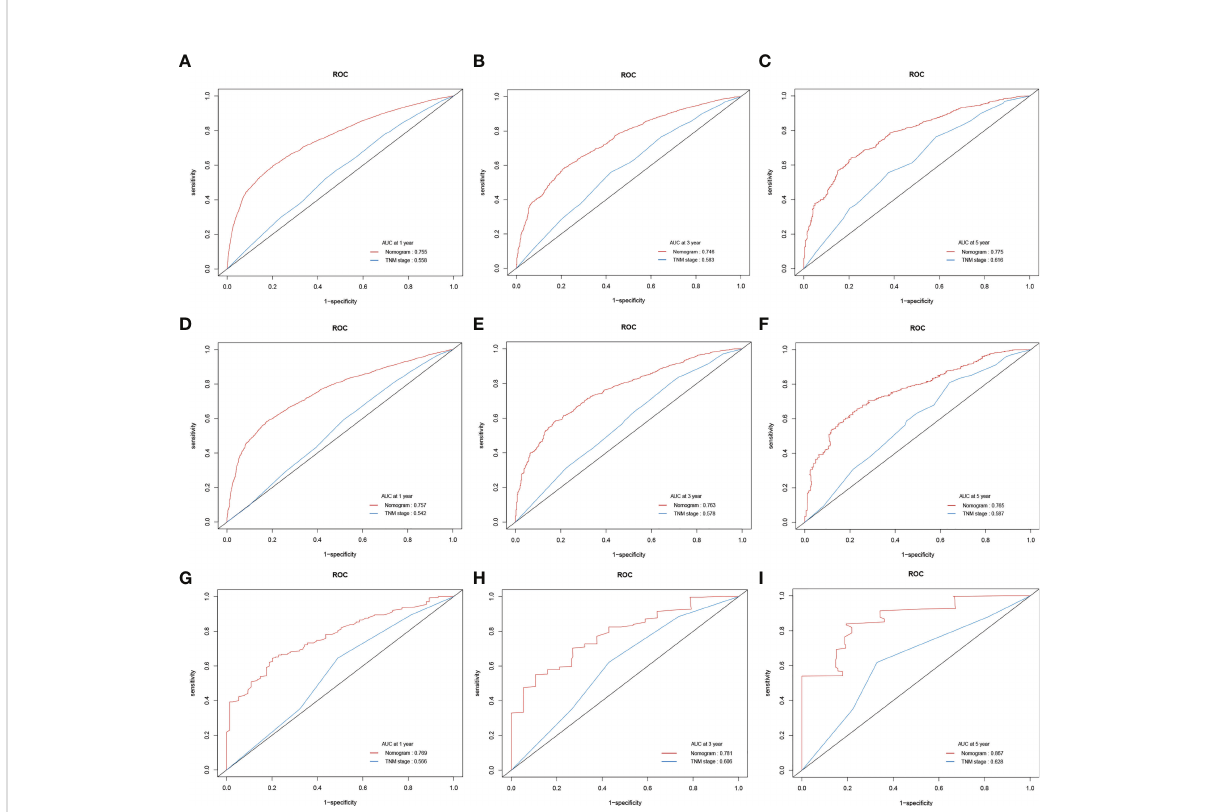
FIGURE 5 The receiver operating characteristic (ROC) curve of the TNM stage and the overall survival (OS) nomogram. (A – C) The area under the curve (AUC) values of ROC predicted 1-, 3-, and 5-year OS rates of the nomogram and TNM stage in the training cohort. (D – F) AUC values of ROC predicted 1-, 3-, and 5-year OS rates of the nomogram and TNM stage in the internal validation cohort. (G – I) AUC values of ROC predicted 1-, 3-, and 5-year OS rates of the nomogram and TNM stage in the external validation